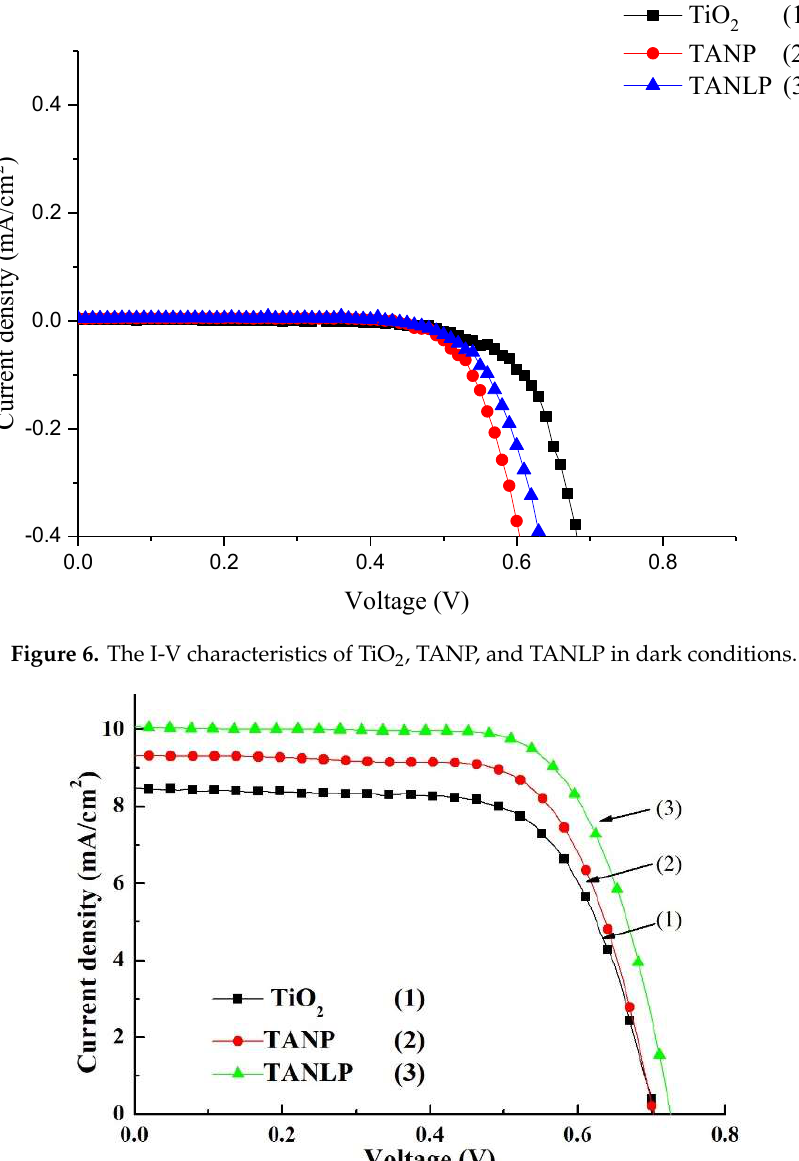
Figure 7. Current density–voltage curves of the DSSCs with different photoelectrodes.